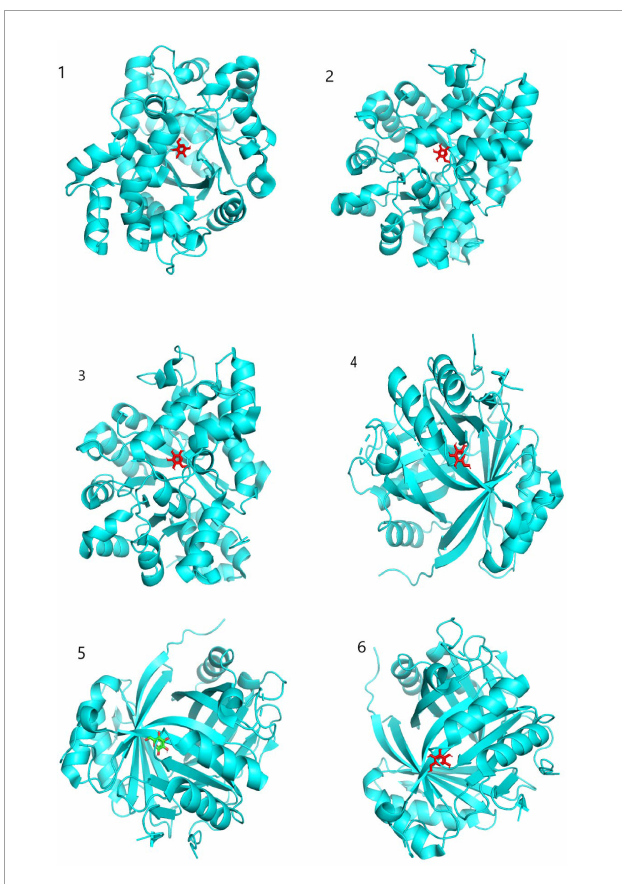
FIGURE5 Molecular docking model diagram. 1: Glucose connects to ADA; 2: galactose connects to ADA; 3: D-Mannose connects to ADA; 4: glucose connects to GLB1; 5: galactose connects to GLB1; 6: D-Mannose connects to